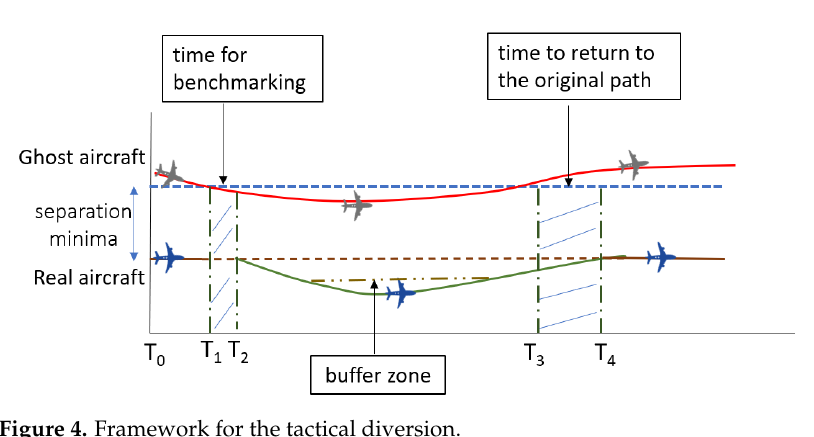
Figure 4. Framework for the tactical